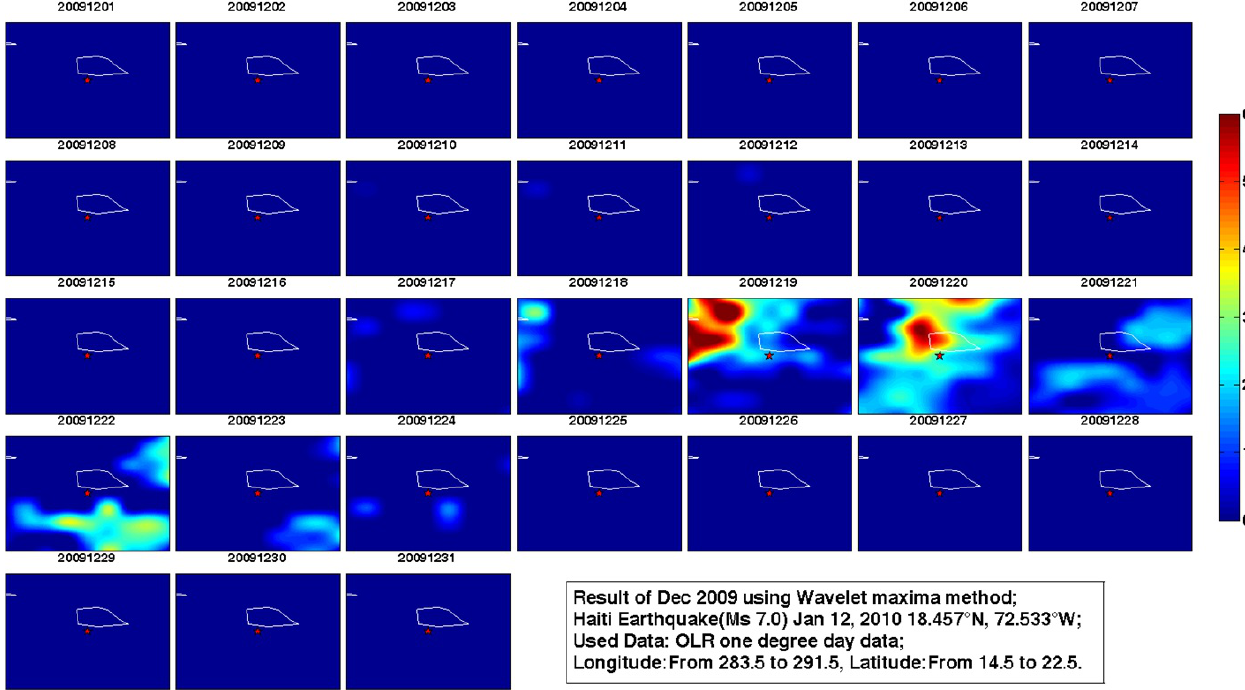
Fig. 8. Wavelet maxima curves based on spatial continuity analysis of December 2009. Epicenter is marked with red star, tectonic plate boundaries with white